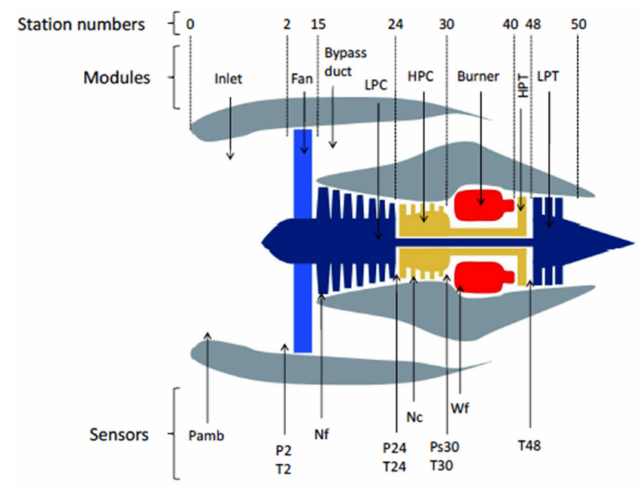
Figure A1. Two-spool turbofan engine layout